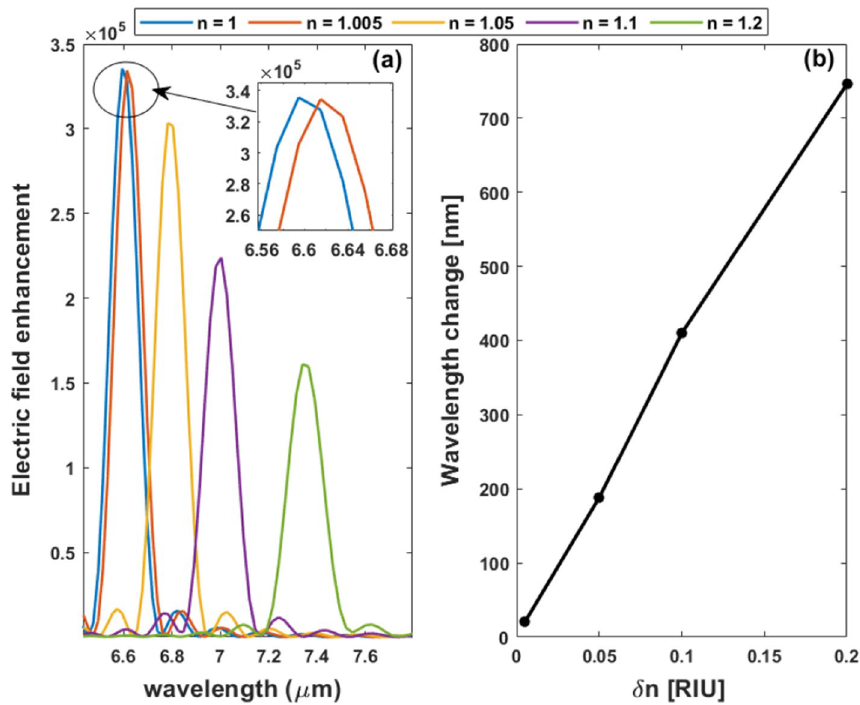
Figure 15. Electric field intensity at the center of the gap ( x = 0, y = 0) as a function of the wavelength for different medium refractive indices and ( b ) the resonance wavelength shift with varying RI for the tapered nanoantenna on the coupled structure with a